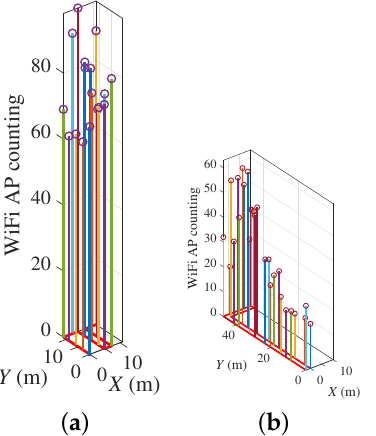
Figure 3. WiFi distribution. ( a ) An Laboratory. ( b ) An Office Building.